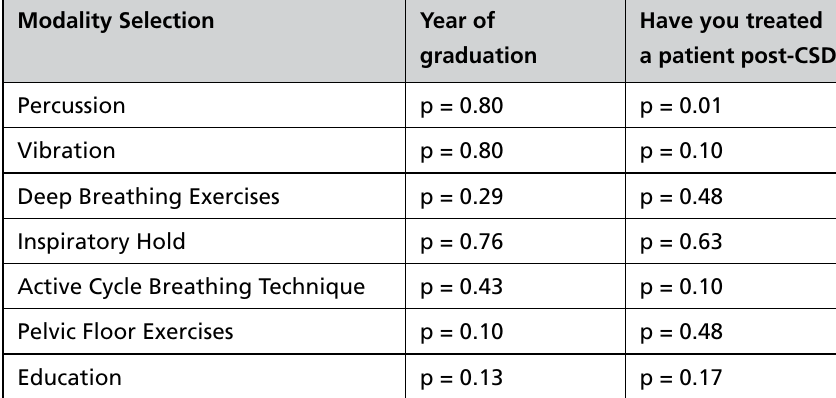
table 1: Modality selection vs year of graduation and treatment of women post-